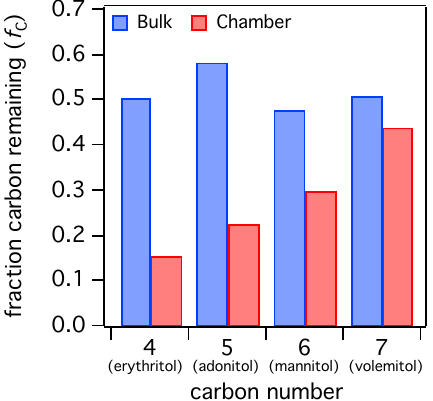
Figure 5. The fraction of carbon remaining in the condensed phase after oxidation ( f C ) in the bulk solution (blue bars) or in submi- cron particles (red bars), as calculated from Eq. (2), using high- resolution V-mode data. Meaningful values could not be determined for the oxidation of glycerol (C3) due to evaporation from the par- ticle phase prior to